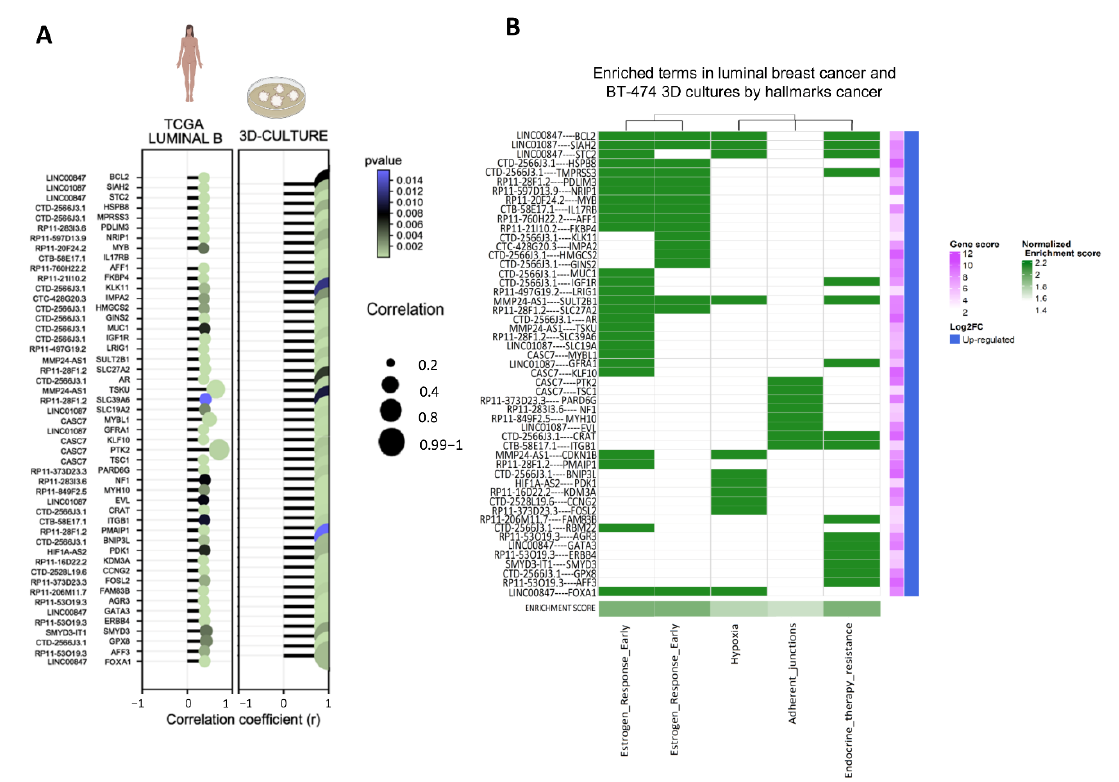
Figure 6. Co-expressed lncRNAs/mRNAs individual pairs in both 3D cultures and TCGA breast cancer (Lumina B). ( A ) Comparison of Pearson’s R values of lncRNAs/mRNAs pairs found in 3D cultures and luminal B breast cancer samples. ( B ) lncRNAs/mRNAs pairs in cancer hallmarks in co-expressed in 3D cultures and luminal B breast cancer.